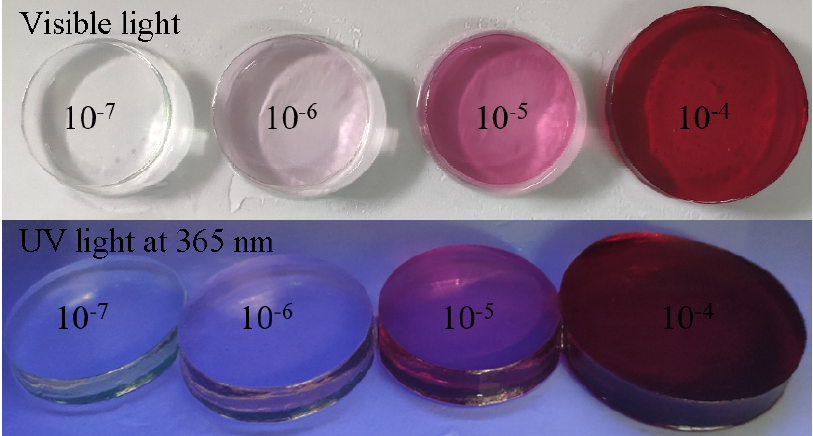
Figure 8. The color of the hydrogel sensor in the presence of different concentrations of H 2 O 2 under visible light and UV light at 365 nm.